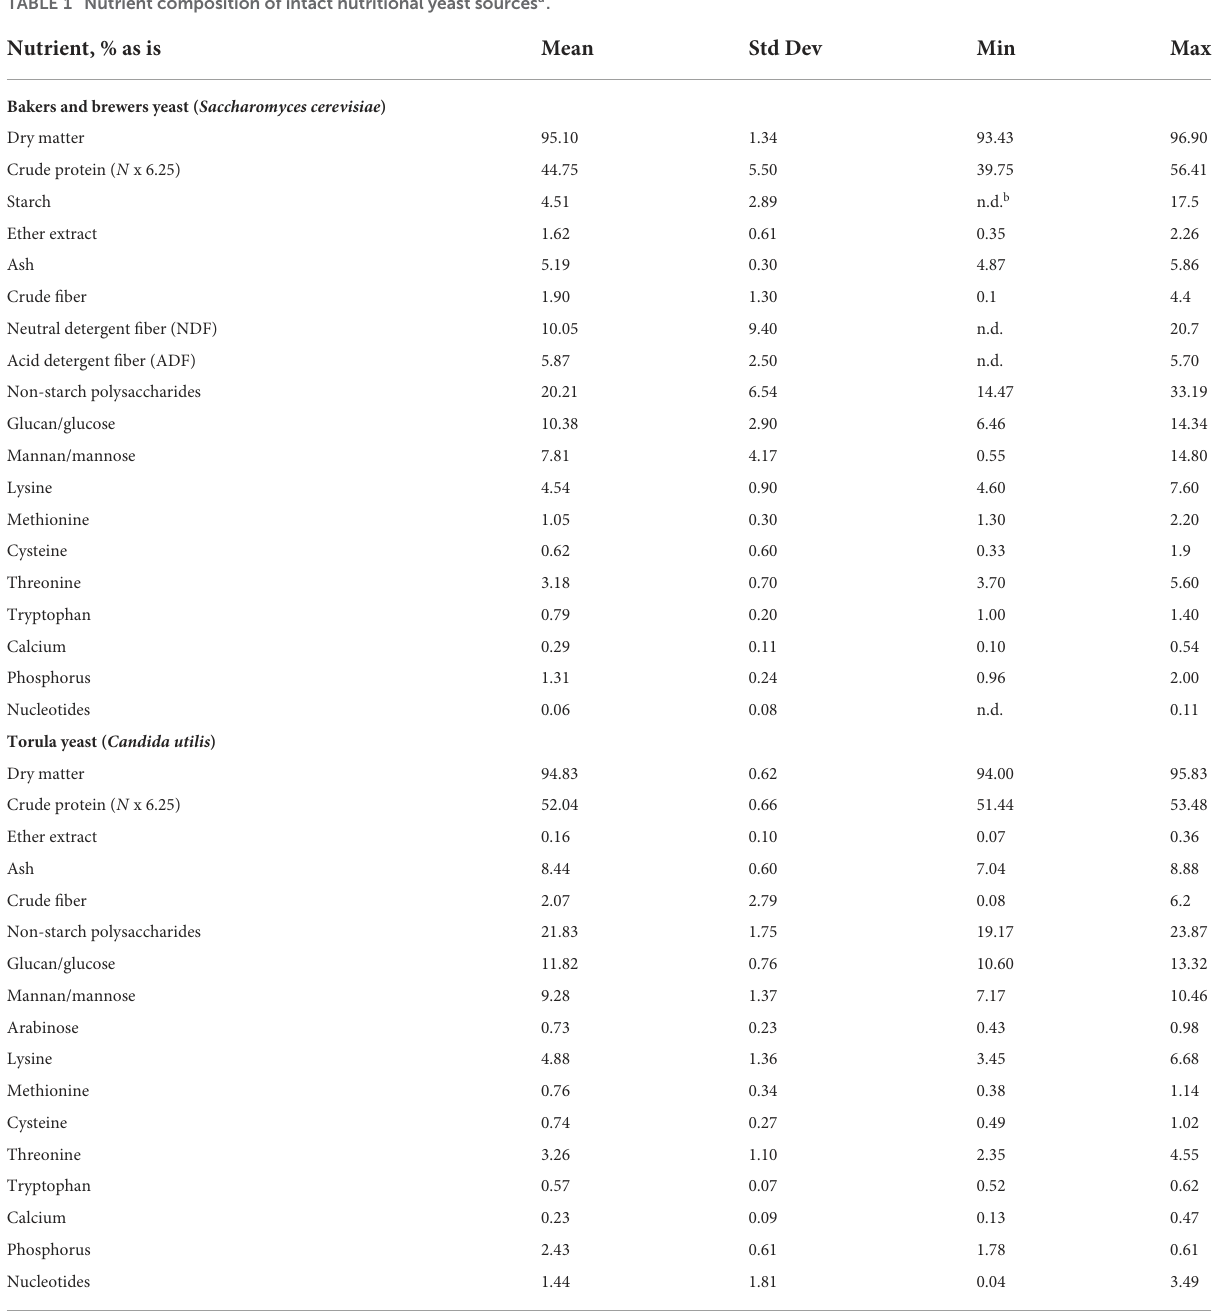
TABLE 1 Nutrient composition of intact nutritional yeast sources a